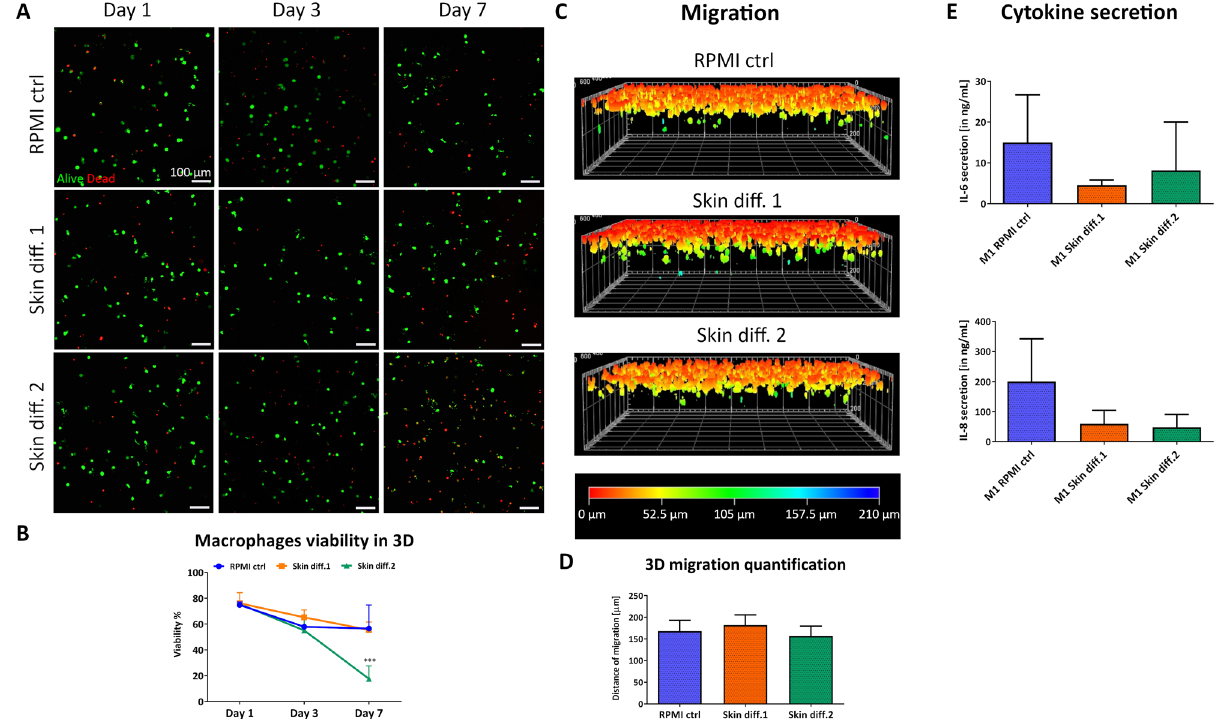
Figure 3. Influence of culture medium composition on viability, response to pro-inflammatory stimuli and migration ability of macrophages in a 3D environment. ( A ) Representative maximum intensity projections of macrophages after culture in RPMI control (“RPMI ctrl”), skin differentiation 1 (“Skin diff. 1”) or skin differentiation 2 (“Skin diff. 2”) media, upon live/dead staining. Scale bars: 100 µm. ( B ) Quantification of macrophage viability. N = 3, n = 2. Error bars represent standard deviation. Statistical significance indicated with *** p < 0.001. ( C ) Representative 3D reconstructed images of live/dead staining after vertical invasion assay, color coded for invasion depth. ( D ) Quantification of macrophage maximal migration distance. N = 3, triplicate measurements. Error bars represent standard deviation. ( E ) Quantification of pro-inflammatory cytokines IL-6 and IL-8 secretion in supernatants. N = 3, duplicate measurements. Error bars represent standard